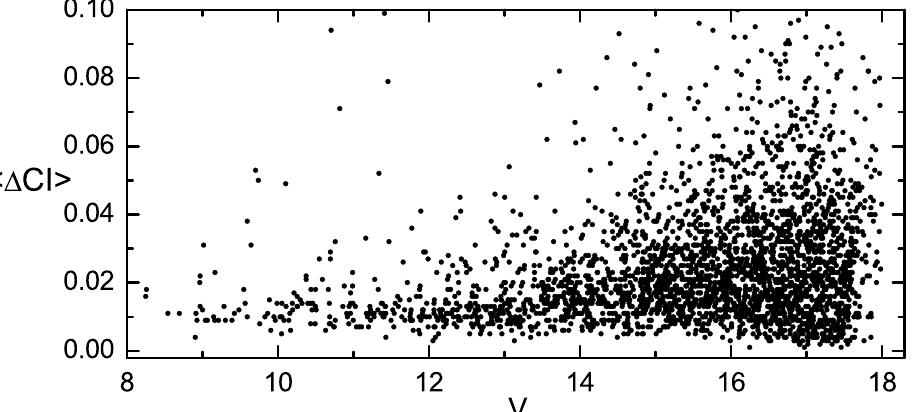
V Fig. 3. Mean differences between the dereddened color indices and those of the closest